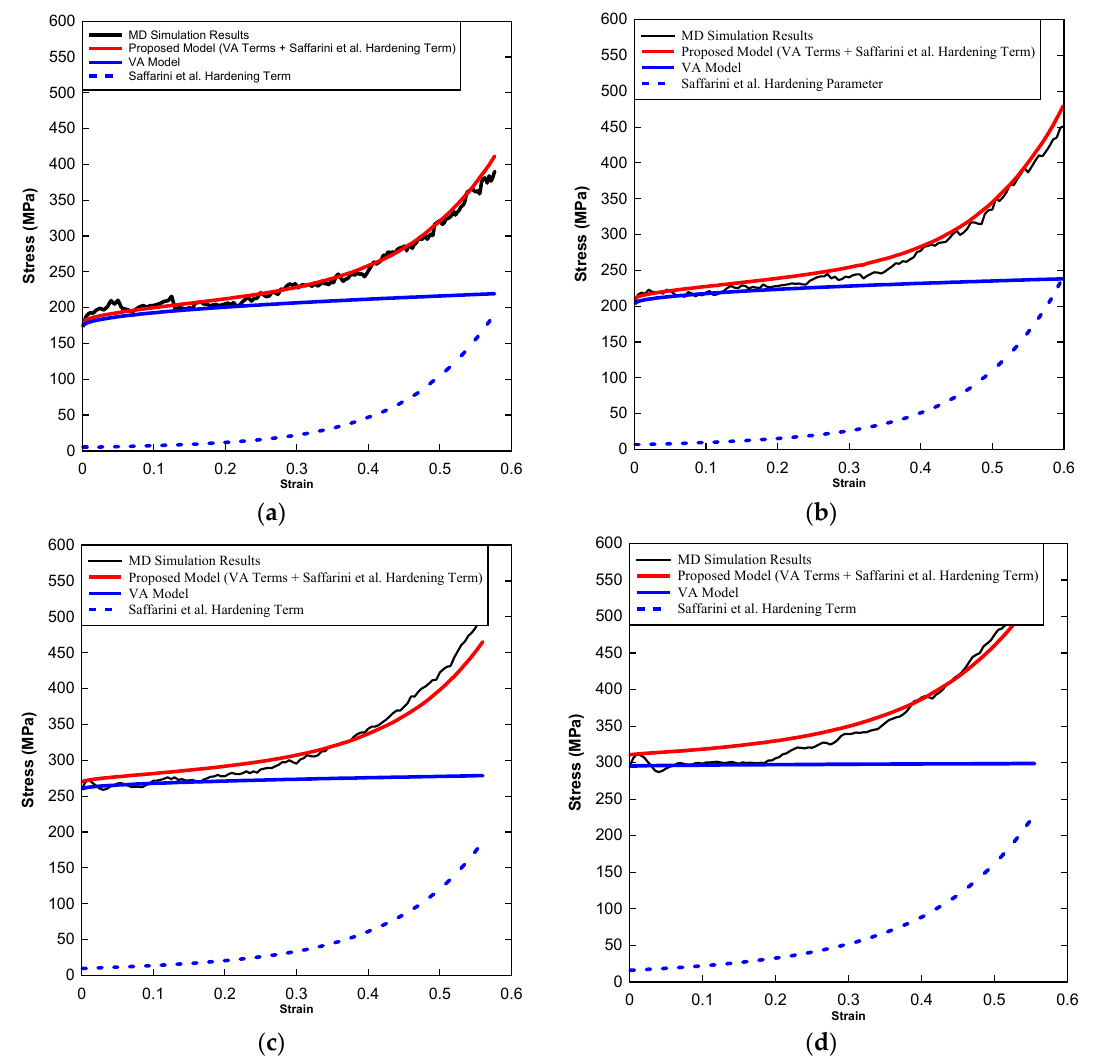
Figure 3. Model predictions of the plastic flow in gold foam compared to the MD simulation results performed in this work, the VA model predictions, and the hardening term from the Saffarini et al. model (dislocation-controlled stress component) in Equation (1) at ( a ) 𝜀(cid:4662) = 10 (cid:2875) s (cid:2879)(cid:2869) , ( b ) 𝜀(cid:4662) = 10 (cid:2876) s (cid:2879)(cid:2869) , ( c ) 𝜀(cid:4662) = 5 × 10 (cid:2876) s (cid:2879)(cid:2869) , ( d ) 𝜀(cid:4662) = 10 (cid:2877) s (cid:2879)(cid:2869) . All for the medium-sized sample with 𝐿 = 13.1 nm.